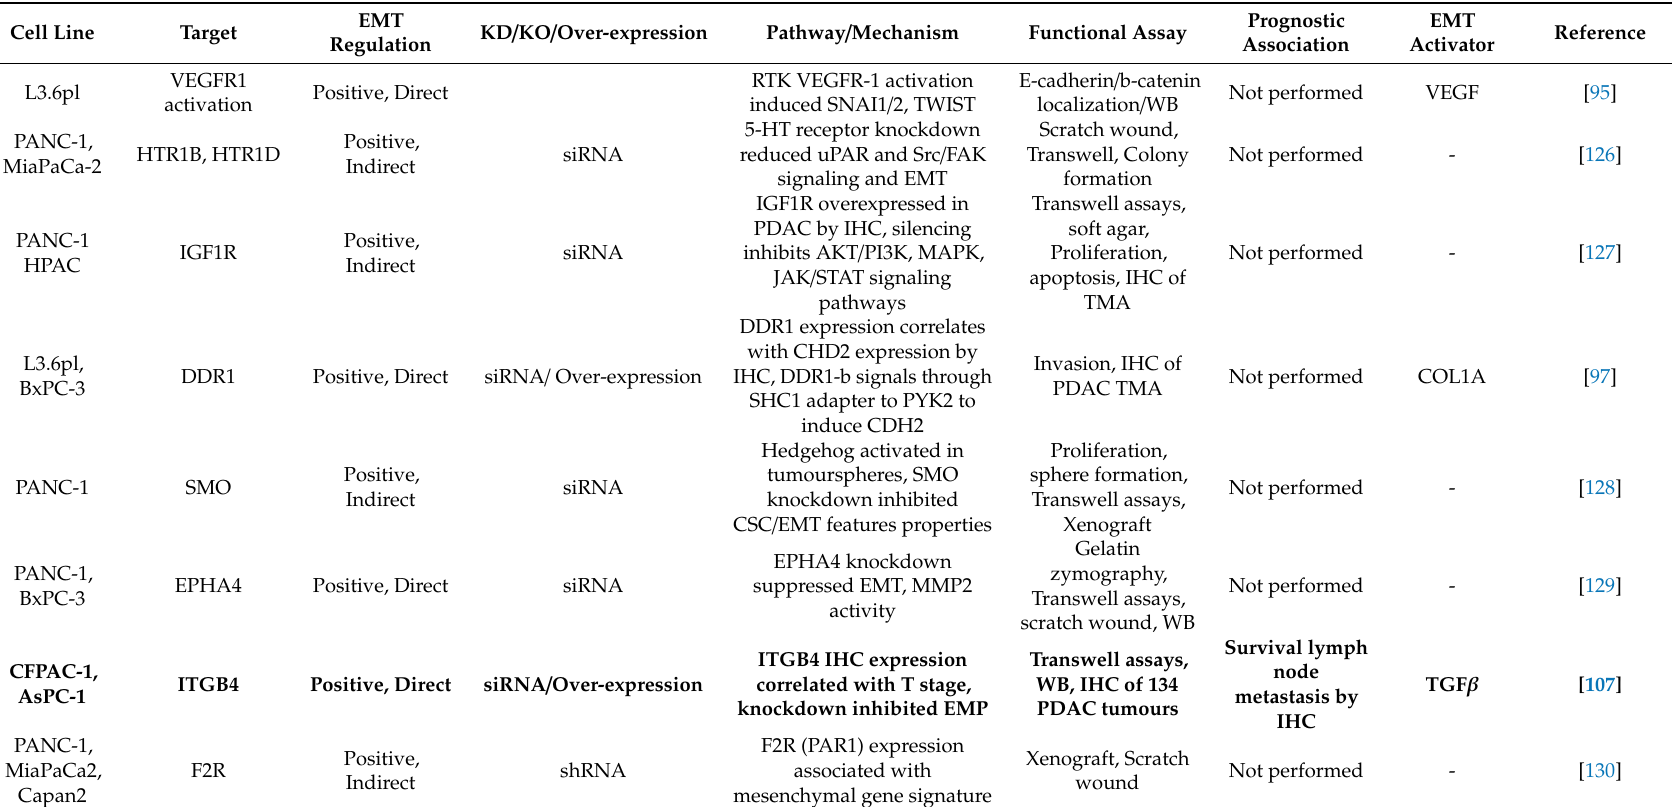
Table 2. Receptors. This table describes known receptors that may be activated to transduce signals required for EMP modulation. Candidates that exhibit clinical correlation with lymph node metastasis are shown in